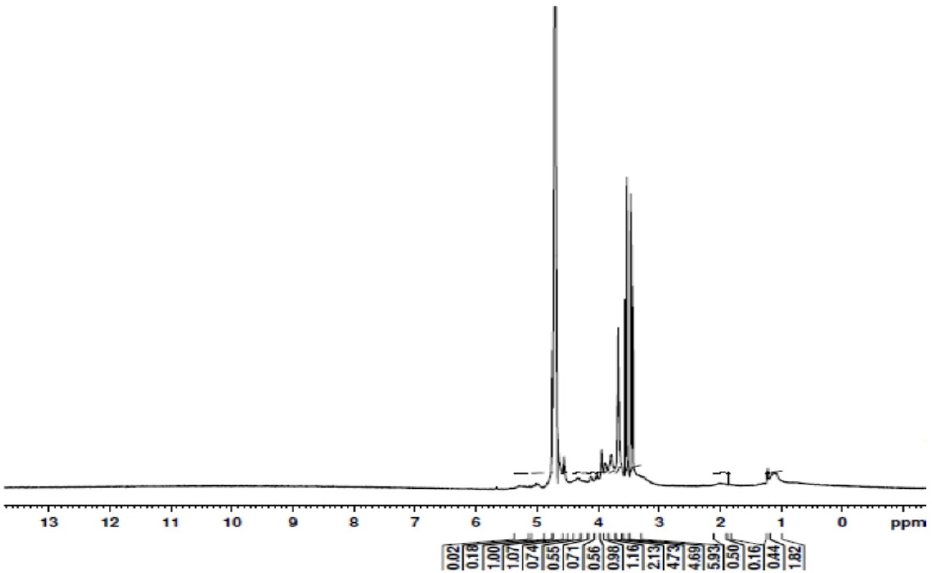
Figure 6. AFM structure of Fucoidan from Sargassum ilicifolium . Figure 7. SEM analysis of Fucoidan from Sargassum ilicifolium .